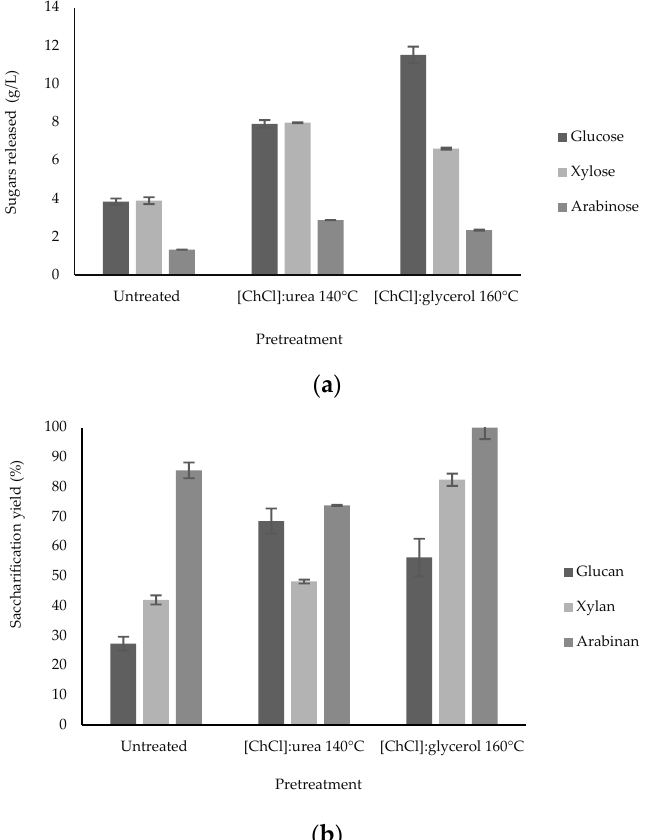
Figure 1. Released sugars ( a ) and saccharification yield ( b ) obtained after enzymatic hydrolysis carried out in SCB untreated and pretreated with different eutectic mixtures.